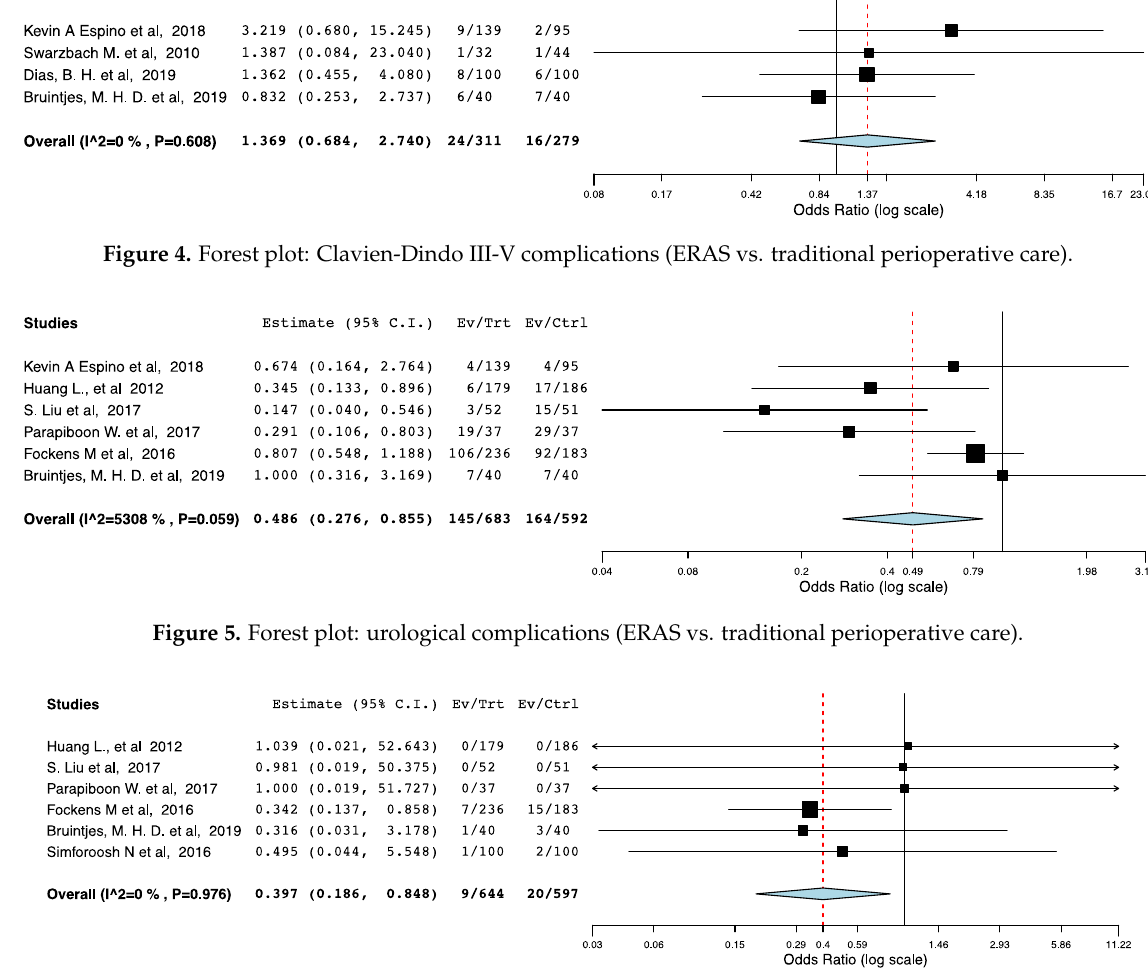
Figure 6. Forest plot: ureteric obstructions or stenoses (ERAS vs. traditional perioperative care).